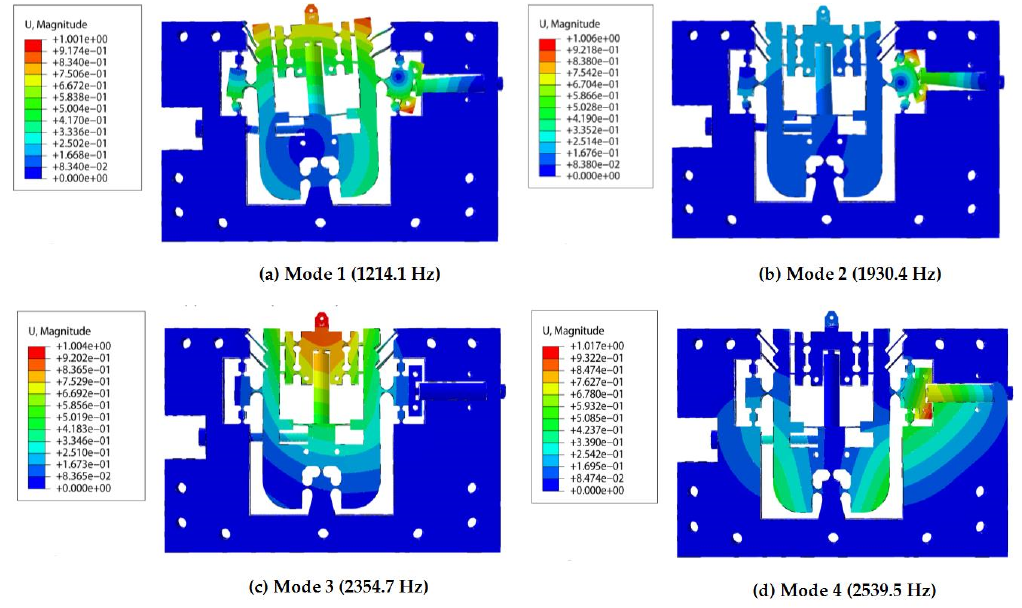
Figure 13. The first four modes of FTS assembly.